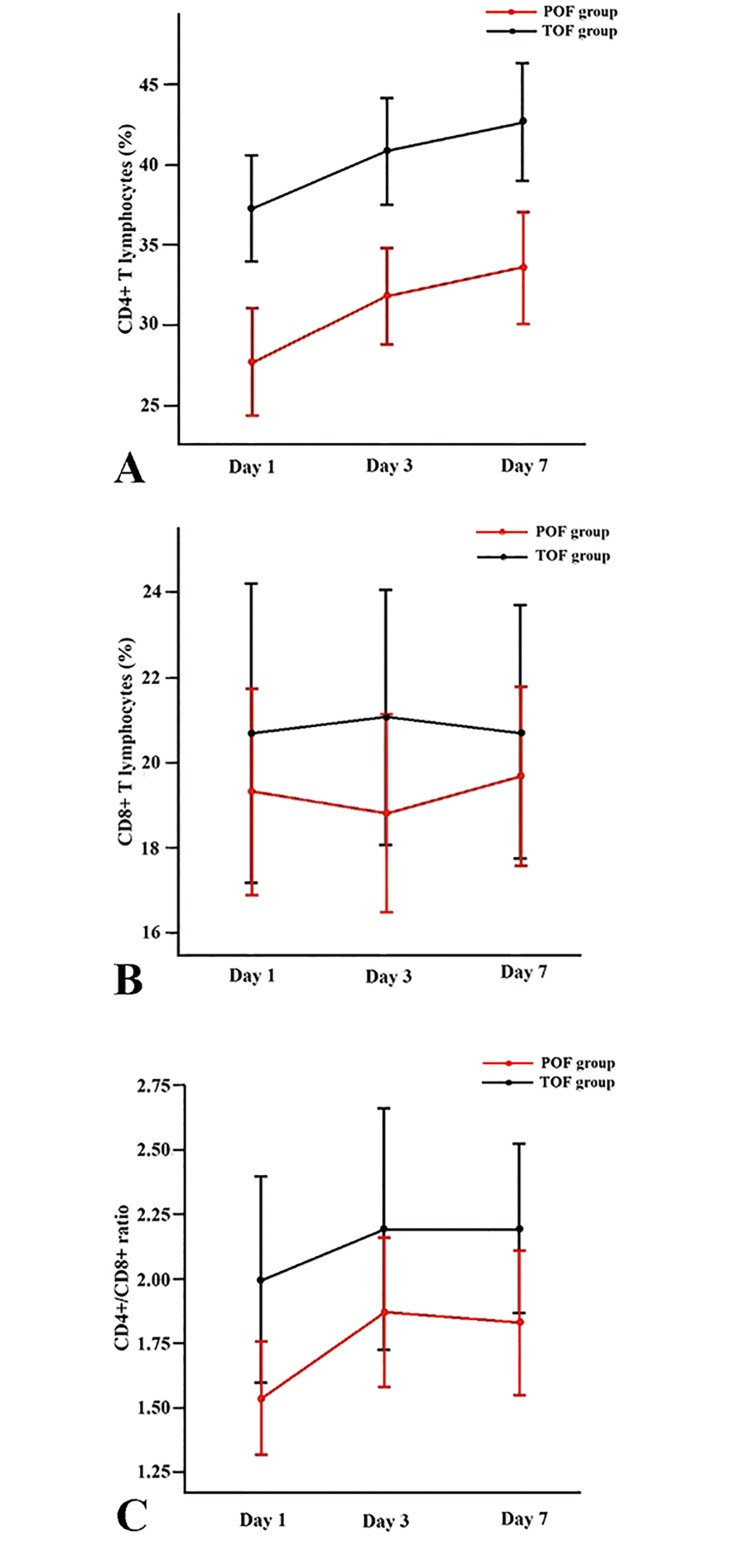
Sequential changes in the proportion of CD4+ T lymphocytes (A), the proportion of CD8+ T lymphocytes (B) and CD4+ / CD8+ ratio (C) in the POF and TOF groups.Data of CD4+ and CD8+ T cells were available in 26, 29 and 30 POF patients on days 1, 3 and 7, respectively.